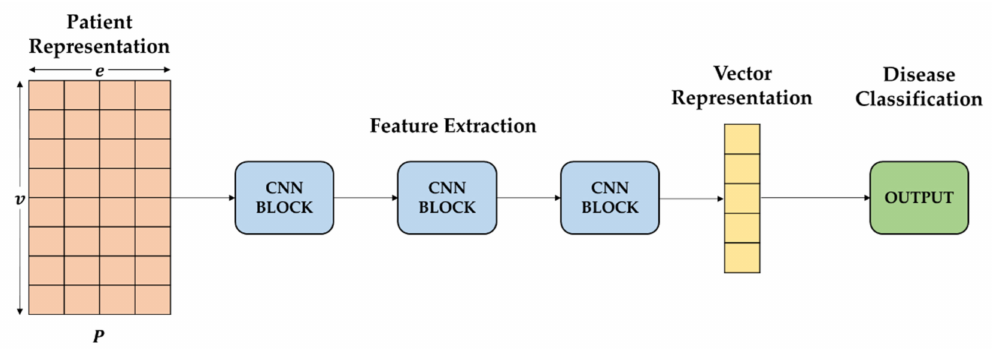
Figure 3. An Illustration of Feature